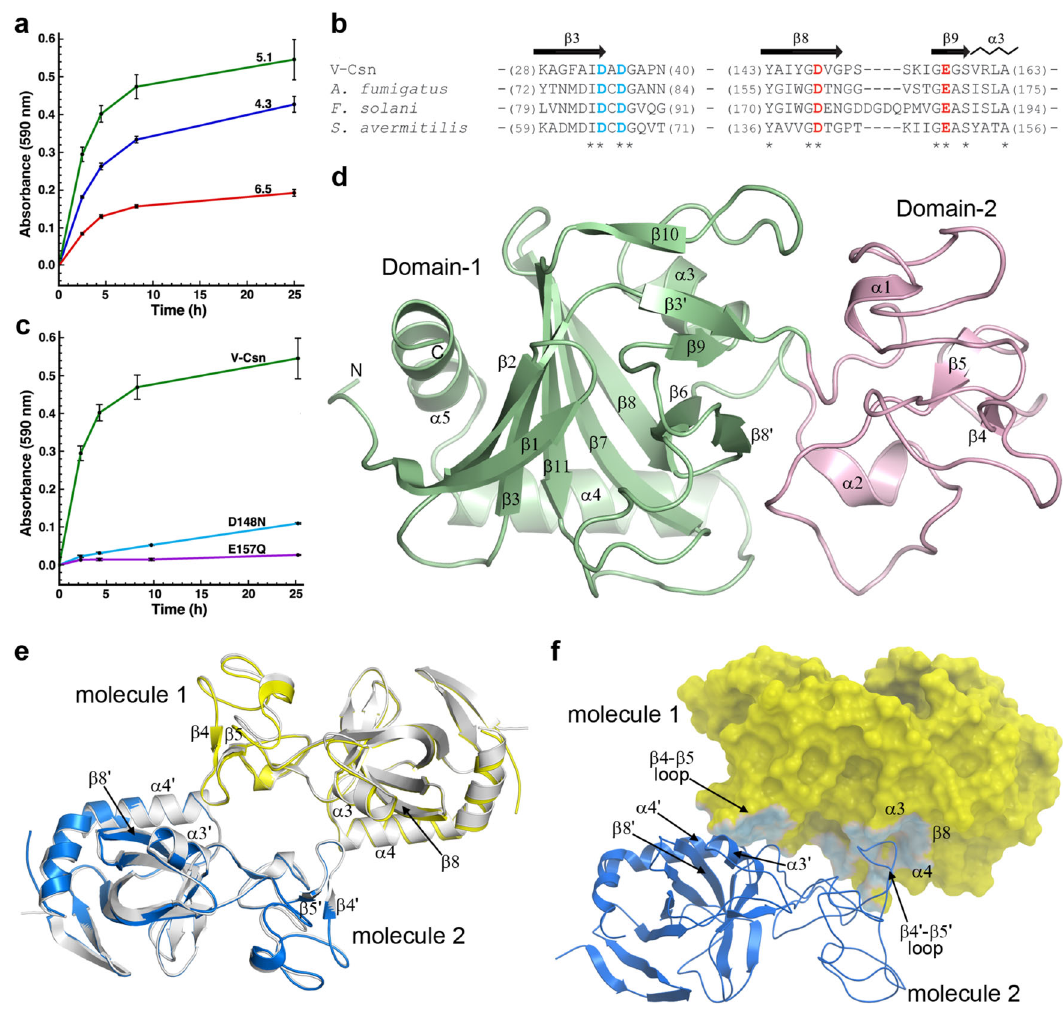
Fig. 2 | The activity and structure of the soil viral chitosanase enzyme V-Csn. a Activity of V-Csn was assayed by monitoring azurine absorbance at 590nm fol- lowing its release as soluble azurine-sugar fragments from an insoluble azurine cross-linked chitosan substrate (AZCL-chitosan). Reactions were performed at room temperature over a range of pH values in acetate buffer. The data represent the mean of replicate experiments ( n =3) with the standard deviation indicated by the error bars. Source data are provided as a Source Data fi le. b Partial sequence alignment of V-Csn with three chitosanase enzymes from Aspergillus fumigatus , Fusarium solani and Streptomyces avermitilis . The secondary structure for V-Csn is indicatedabovethealignment.Fourconservedacidicresiduespotentiallyinvolved in catalysis are colored blue and red. Alignment of available sequences of GH75 family enzymes show that only six positions are universally conserved, these four acidic residues and two glycine residues, as indicated by the asterisks beneath the alignment. c Release of azurine by wild-type V-Csn and two constructs containing